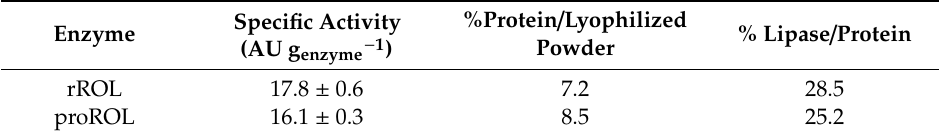
Table 3. Specific activity, mass/mass % of total protein/lyophilized powder, and ratio lipase/protein of proROL and rROL calculated with the Western blot test. Specific Activity Enzyme (AU g enzyme − 1 )